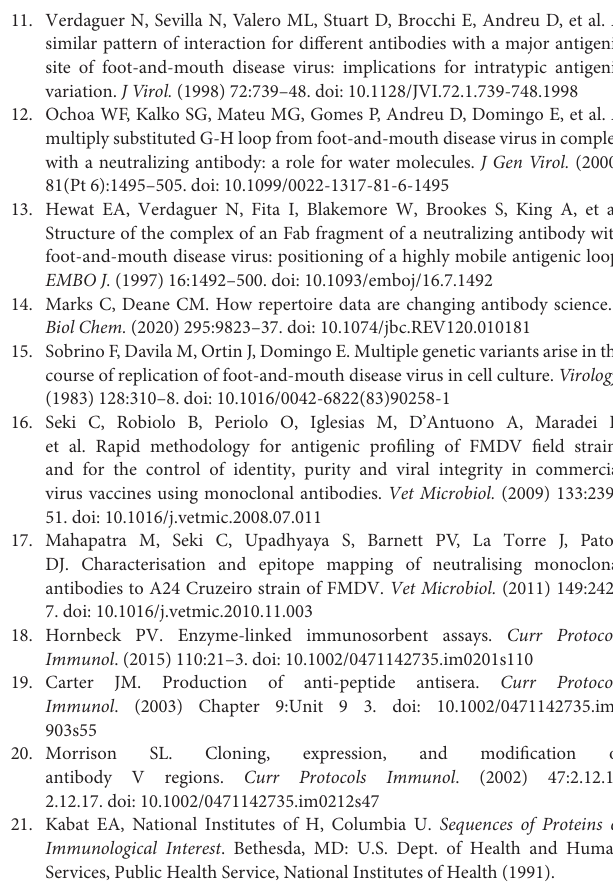
Supplementary Figure 1 | Ag-Ab modeling pipeline. The black outlined rectangles define input points of sequences to the protocol whereas, red, green, blue, and yellow colors refer to modeling stages for the Ag, mAbs, Ag-Ab complexes, and candidate mutational scoring, respectively. Supplementary Figure 2 | H chain-specific mapping of Ag-Ab contact probability. Contact probability at H chain residues of different Abs and FMDV ASA. Data are displayed as a probability contact over the H chains residues of the reference mAb 4C4 (green), and mAbs 4A2 (blue) and 1E12 (red). The contacts are presented from left to right as follows: A, non-bonded interactions; B, Hydrogen bridge interactions (polar) and C, hydrophobic interactions (apolar). Supplementary Figure 3 | L chain-specific mapping of Ag-Ab interaction probability. Non-bonded (NB) interaction probability data per aa residues of the L chains are depicted. The reference 4C4 mAb (green) plot is superposed to 4A2 mAb (blue; A) and 1E12 mAb (red; B) plots. Supplementary Figure 4 | Graphic output from the result page of the HADDOCK web server relative to three different molecular docking experiments. The panels display variable docking clusters obtained from 3 different docking inputs of the same FMDV peptide Ag. Single-state Ag input (A) and two different multiple-state Ag input molecular ensembles obtained after 10 (B) or 50 (C) x,y,z coordinates